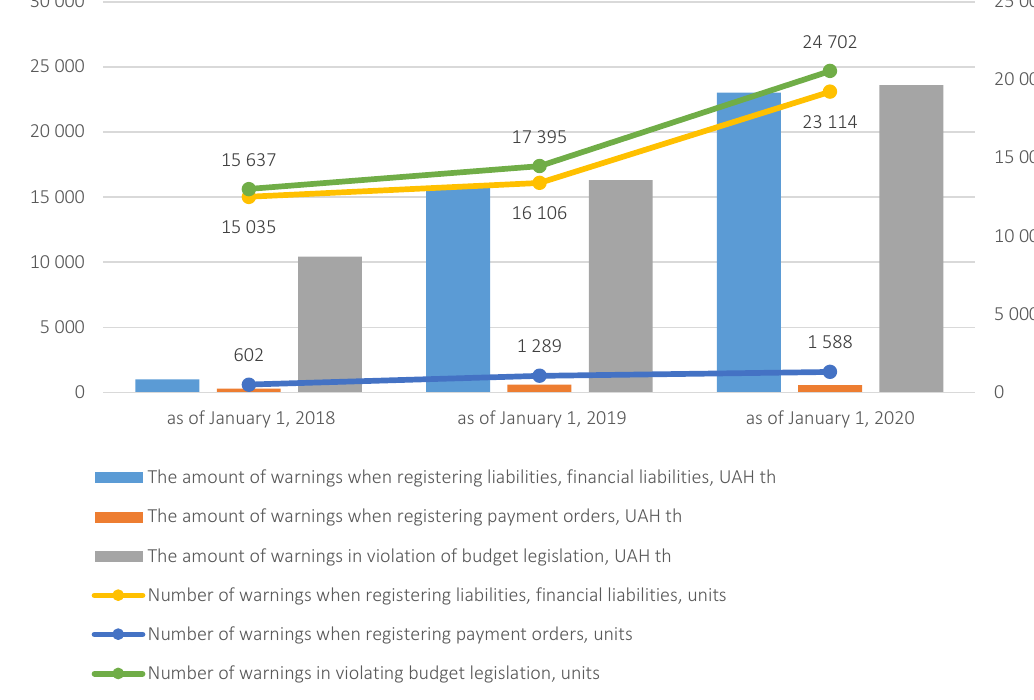
Figure 3. The number and the amounts of warnings for managers and recipients of state and local budgets, identified by the State Treasury Service of